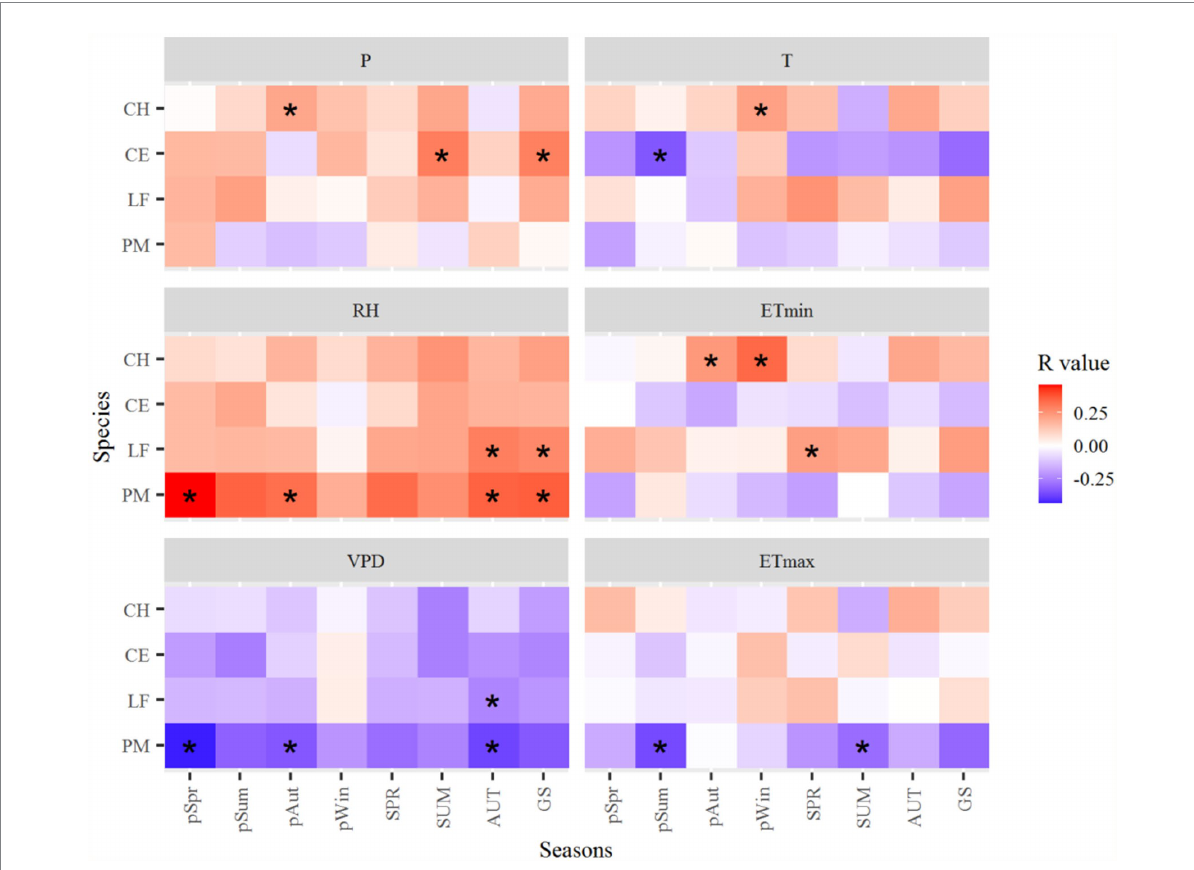
FIGURE 7 Correlation coefficients of the standard tree-ring chronologies in the northern Luoxiao Mountain with seasonal main climate factors during 1958– 2019. P, precipitation, RH, relative humidity, VPD, vapor pressure deficit, T, mean temperature, ETmin, extreme minimum temperature, ETmax, extreme maximum temperature. pSpr, previous year March to May, pSum, previous year June to August, pAut, previous year September to November, pWin, previous year December to current year February, SPR, current year March to current May, SUM, current year June to August, AUT, current year September to November, GS, current year March to November. * p <